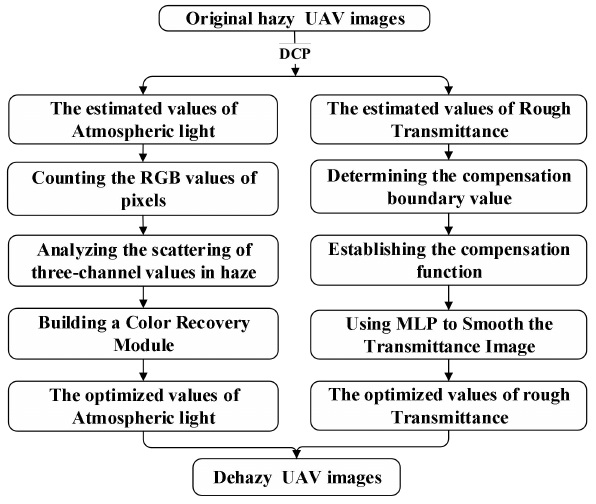
Figure 1. Flow chart of the improved DCP